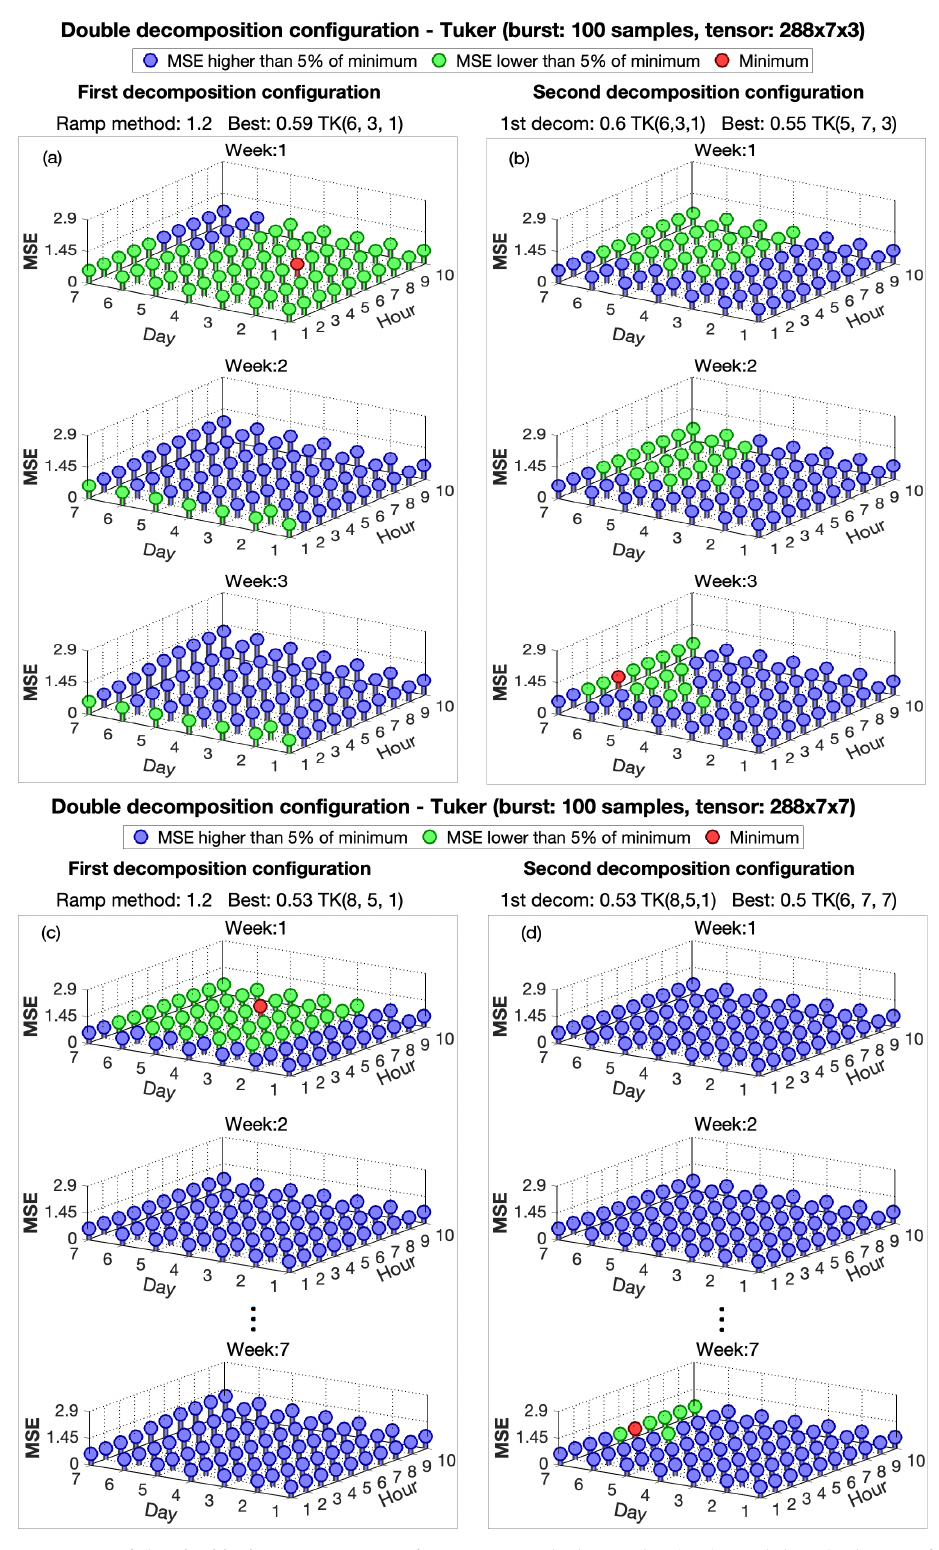
Figure 9. Test of the double decomposition configuration with the Tucker(TK) model and a burst of 100 samples. ( a , c ) show the MSE of the first decomposition procedure for different core configurations. ( b , d ) show the MSE of the second decomposition for different core configurations and using the best core configuration obtained on ( a ) or ( c ) in the first decomposition,